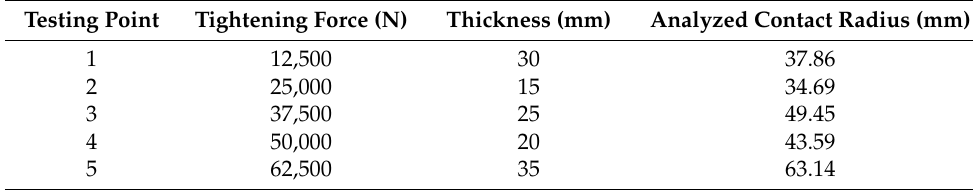
Table 4. The contact radius of testing points.